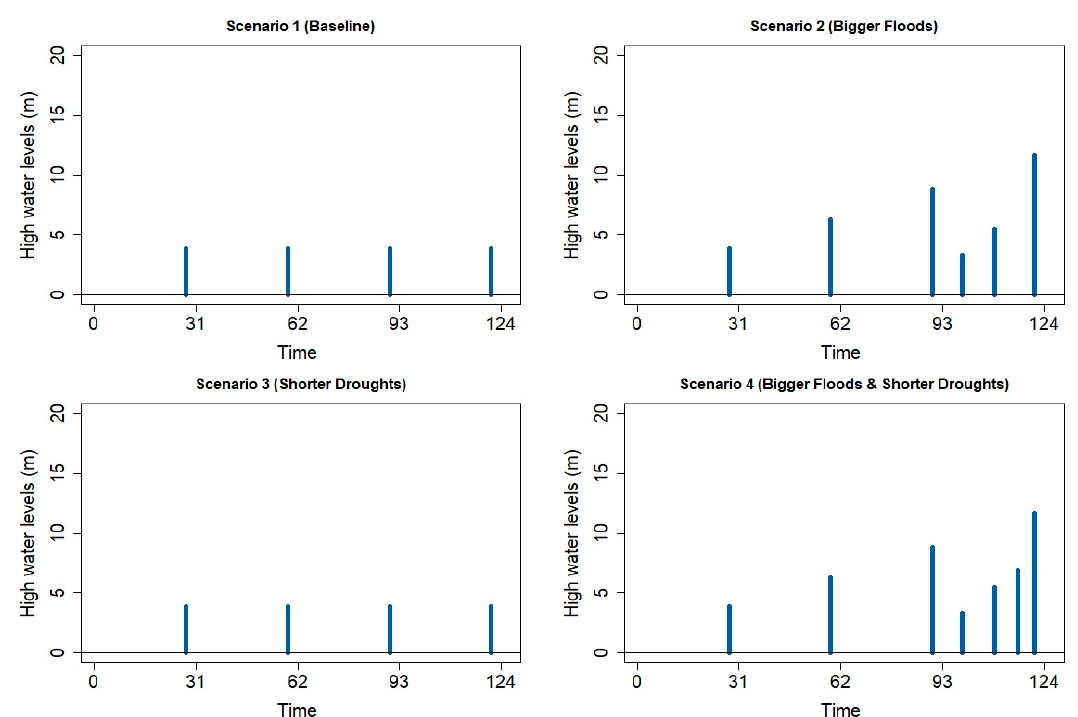
Figure 11. Flood peaks downstream from Wivenhoe Dam resulting from the management of the Dam operated with the calibrated values of bias ( β ) and memory decay rate ( μ ) in response to different future hydrological extremes scenarios.